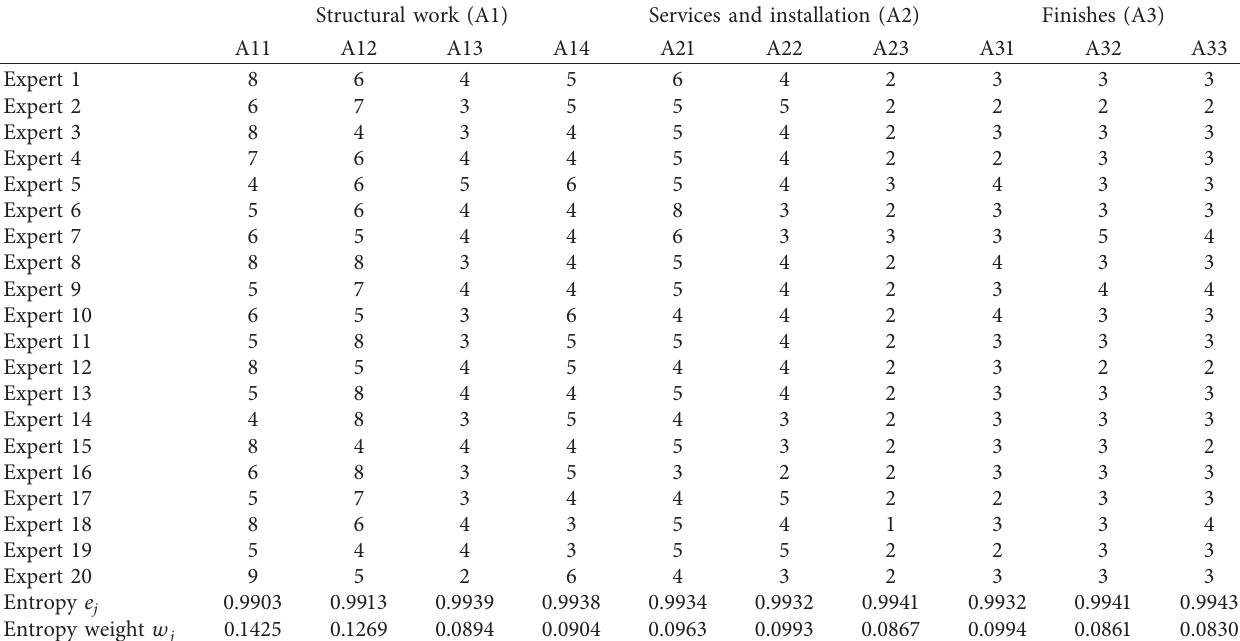
Table 8: The entropy weight table to calculate the objective